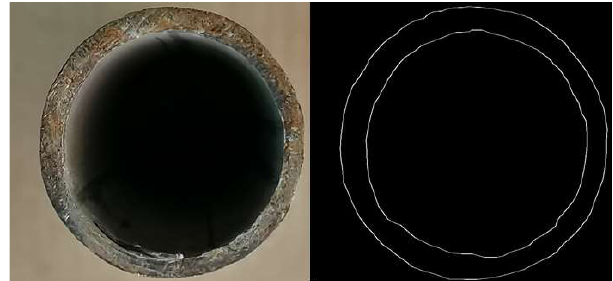
Figure 4. Making a dataset.